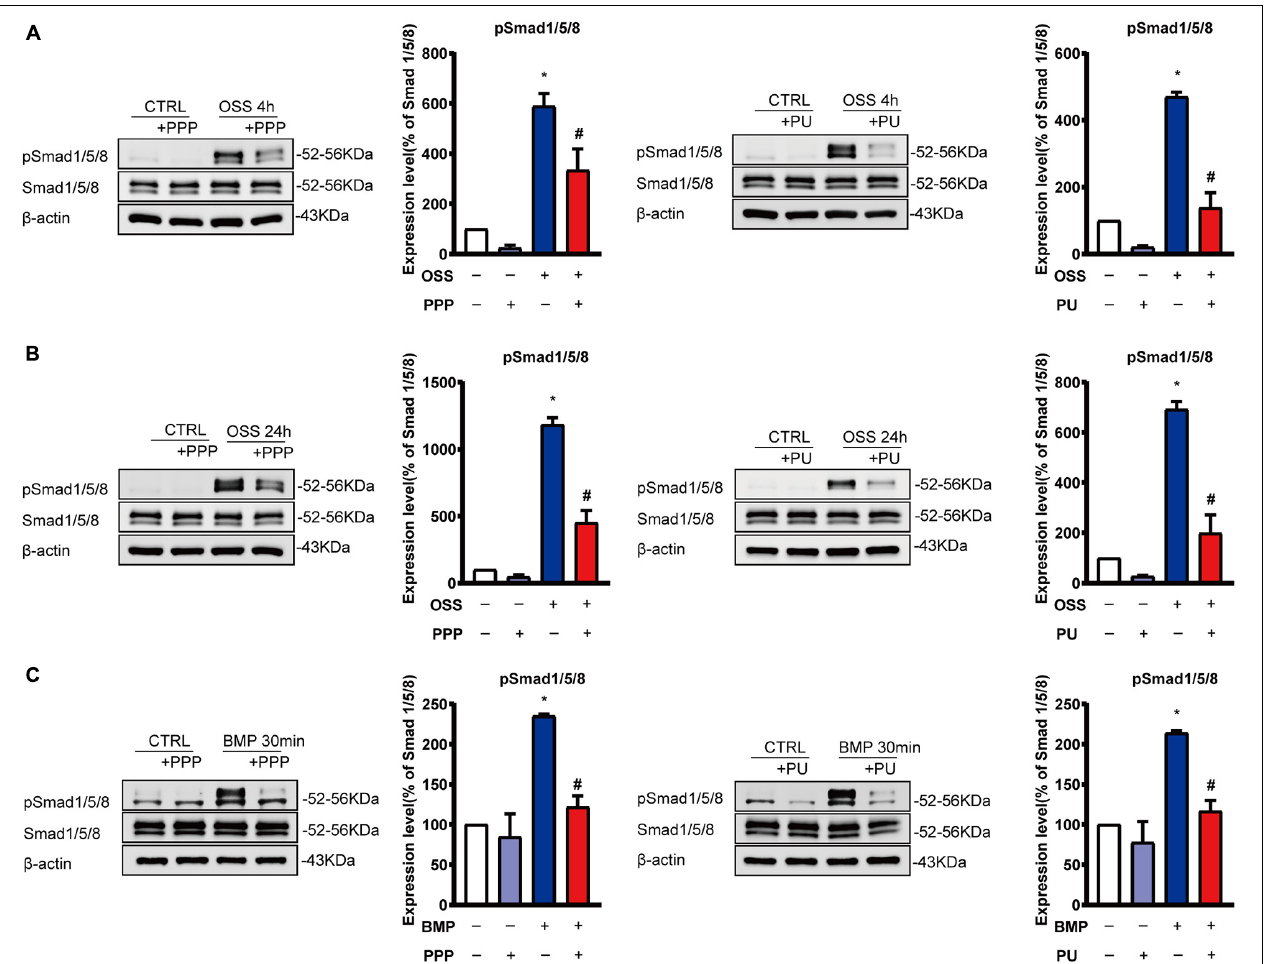
FIGURE 5 | PPP and PU inhibit Smad1/5 activation in ECs induced by OSS or BMP. (A–C) Western blot analysis of protein expression of the indicated molecules in ECs induced by OSS for 4 h (A) or 24 h (B) and BMP for 30 min (C) . Blot is a representative of five independent experiments. * P < 0.05 vs. Vehicle, # P < 0.05 vs.